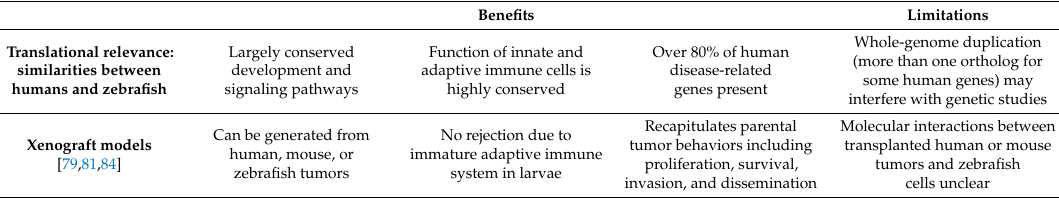
Table 1. Zebrafish in cancer